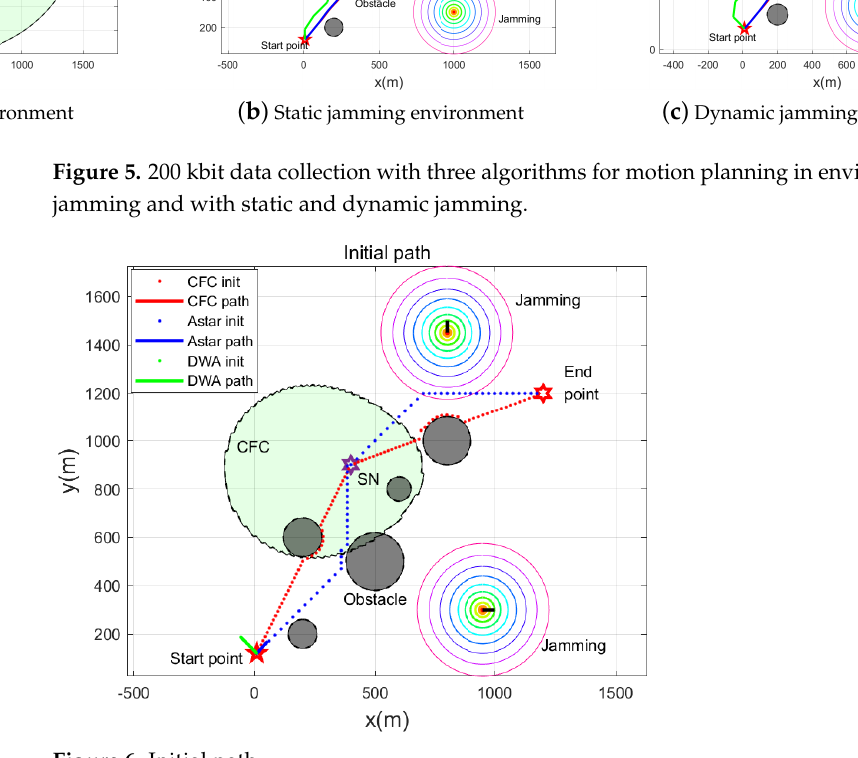
Figure 6. Initial